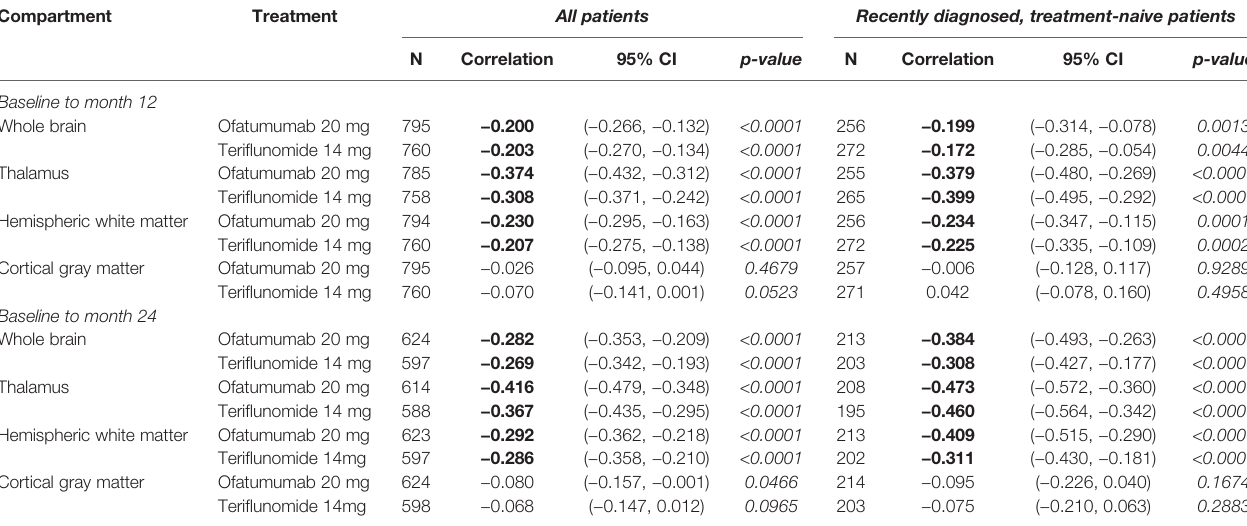
Compartment Treatment All patients Recently diagnosed, treatment-naive patients